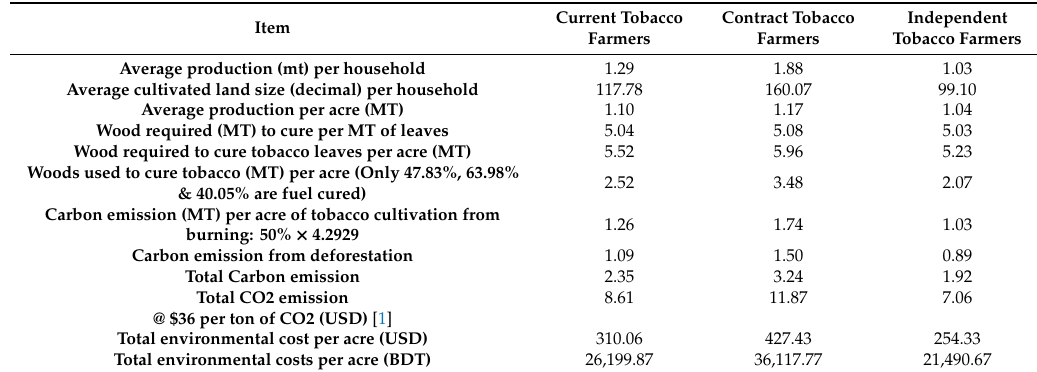
Table 12. Environmental cost of tobacco curing per acre of